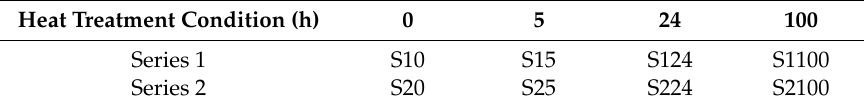
Table 2. Identification of the